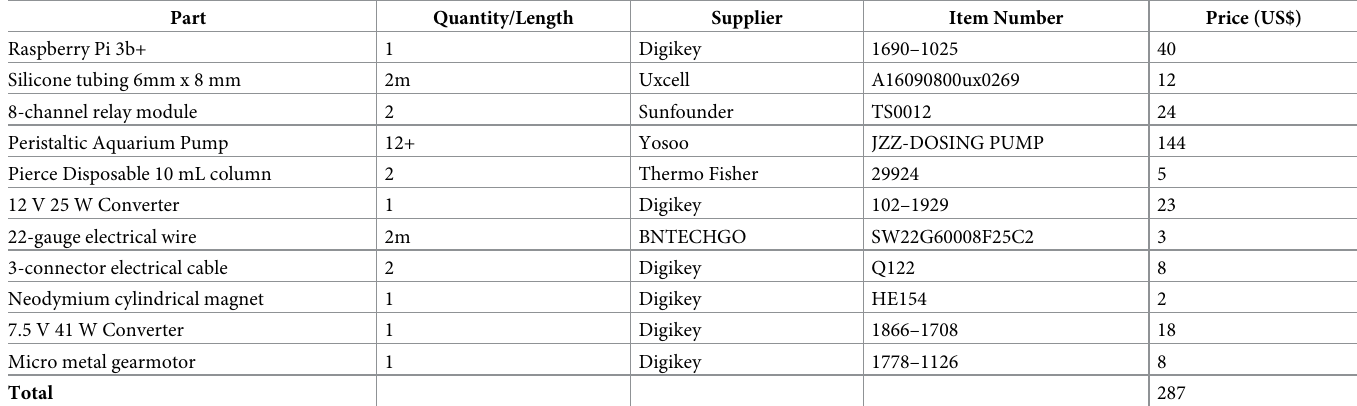
Table 2. Parts list and itemized cost.